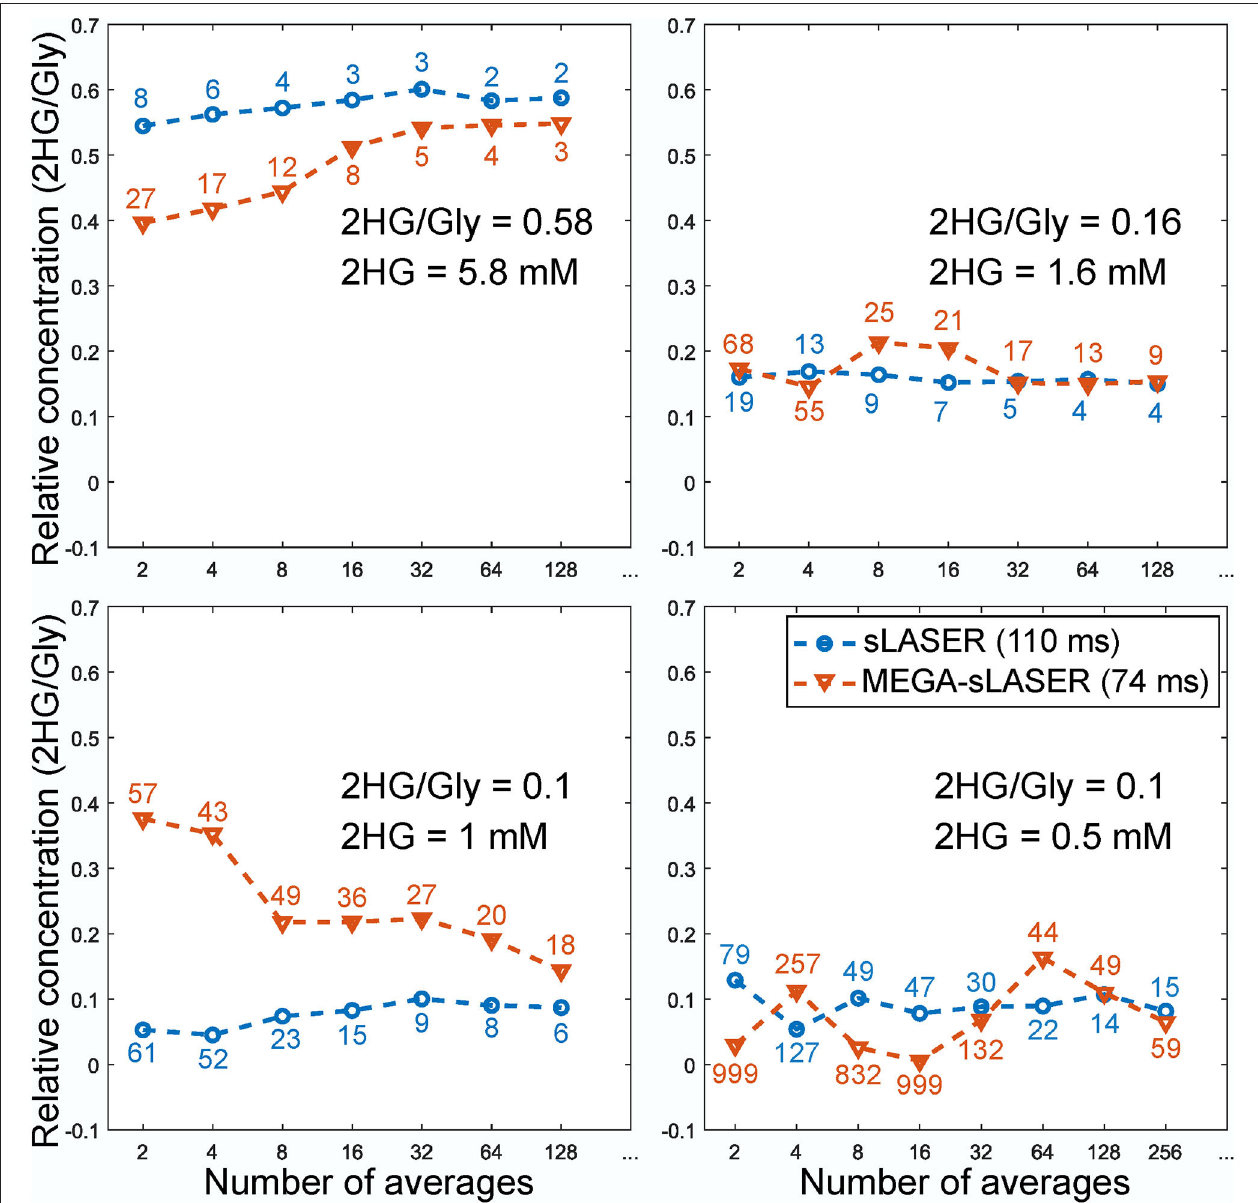
FIGURE 3 | Relative concentration of 2HG to glycine in the phantoms as a function of number of averages. The numbers correspond to the CRLBs of the 2HG fit. The concentration of Gly for MEGA-sLASER measurements was derived from the edit-off spectra.